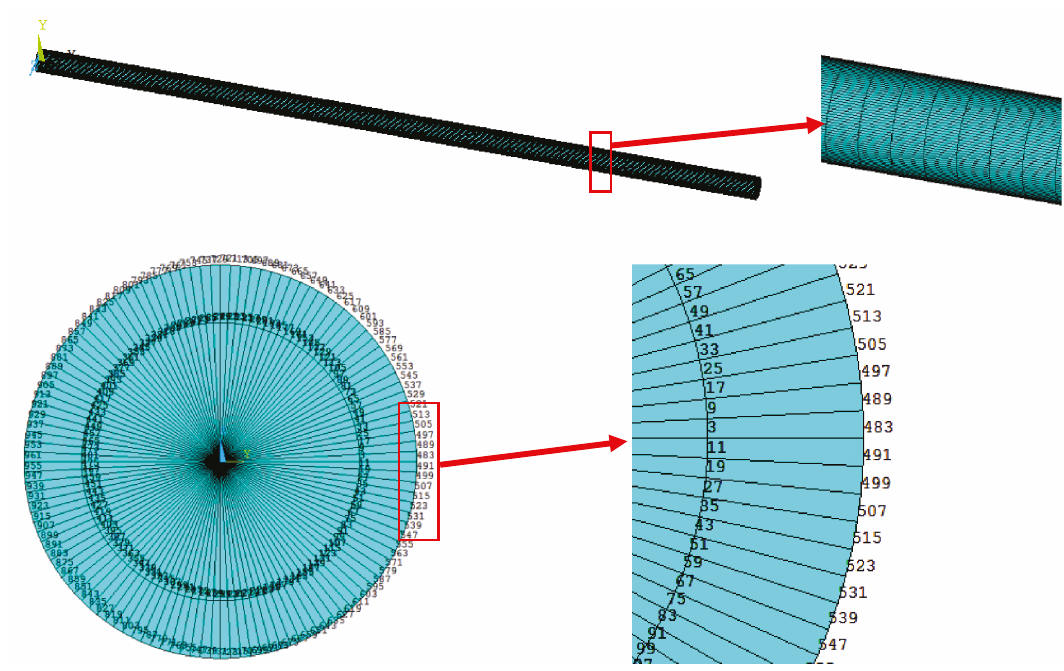
Figure 4: Finite element model of beam and the section division.